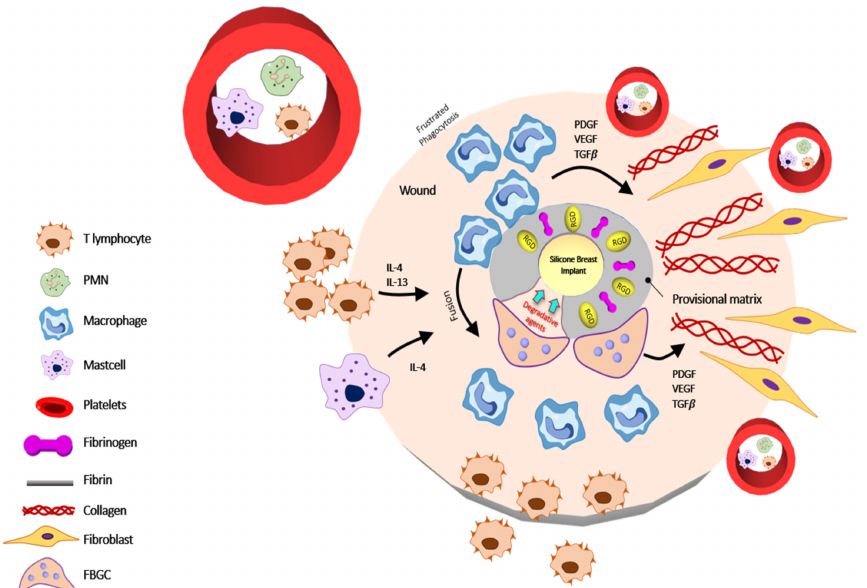
Figure 3. Schematic illustration of Phase 3 after implantation. Chronic inflammation begins with the dominance of macrophages and lymphocytes, which secreted the cytokines IL-4, IL-13. A longer period of chronic inflammation and impaired wound healing leads to the development of granular tissue formation. Reproduced with permission from [31].